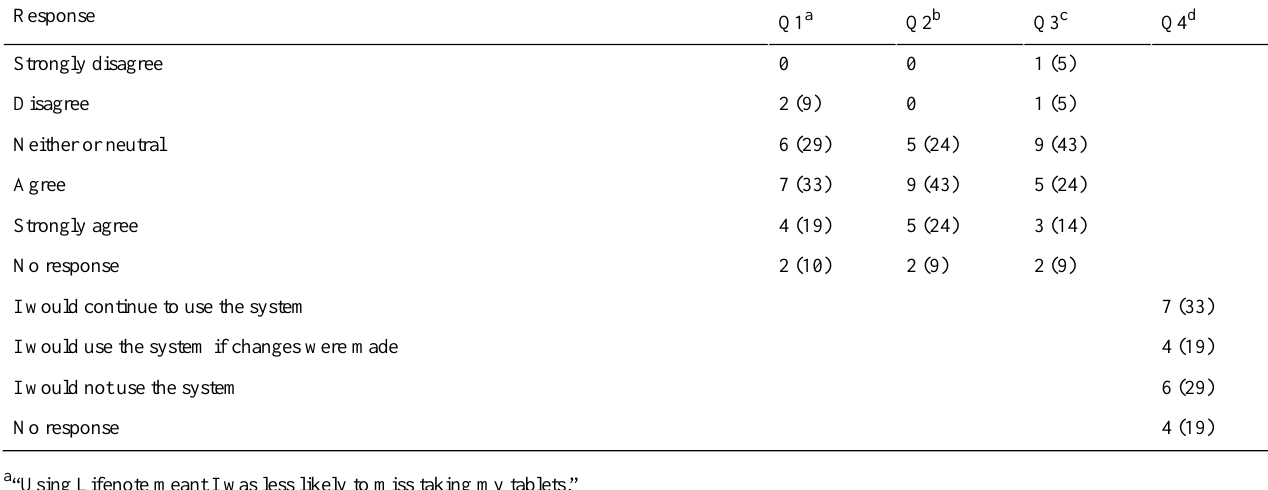
Table 2. Number (%) of participants’choosing each possible response to questionnaire items regarding acceptability